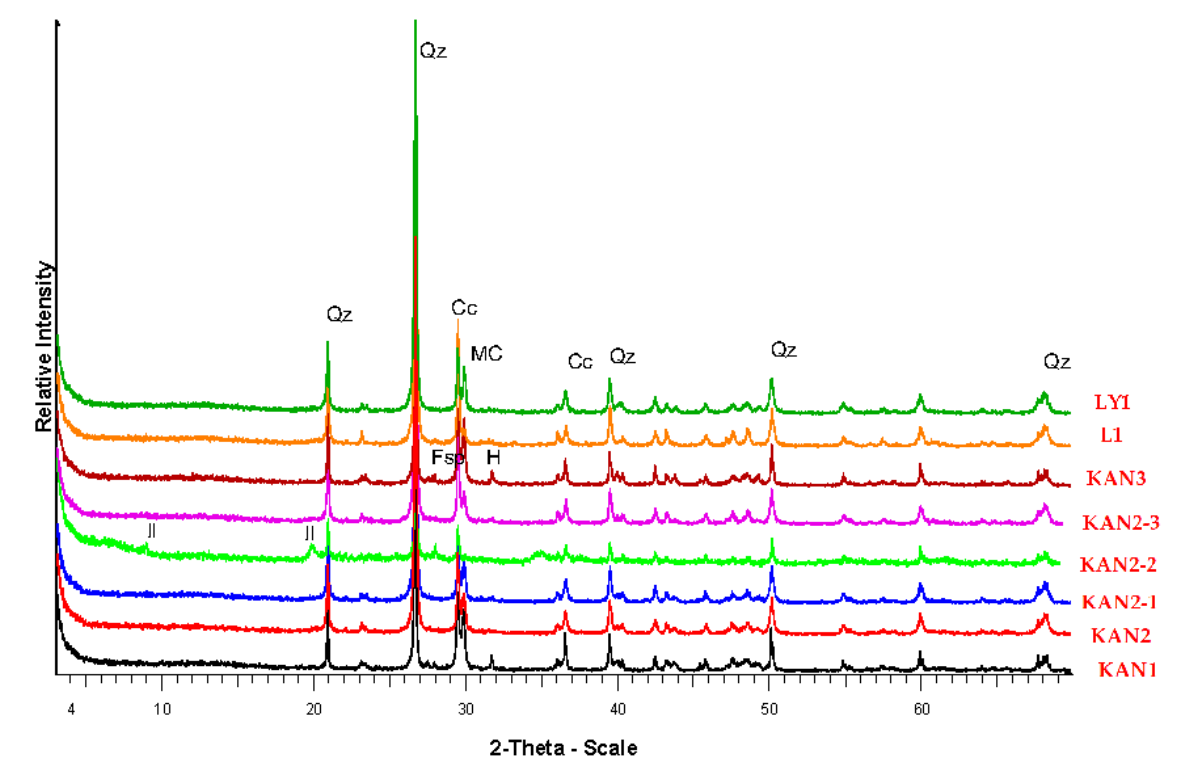
Figure 8. XRD analyses of mineral compositions of studied samples. Cc: calcite, MC: Mg-calcite; Fsp: feldspar; H: halite; Il: illite; Qz: quartz.